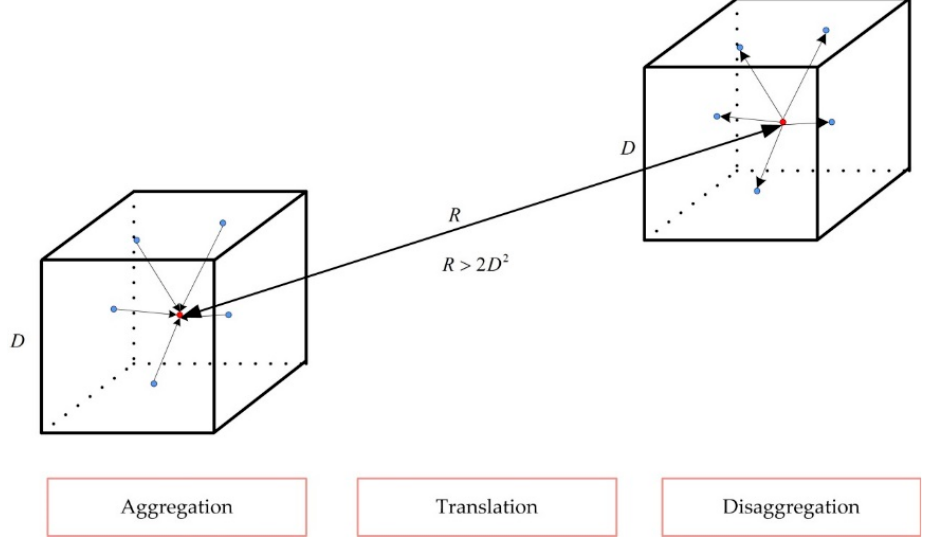
Figure 2. Far fi eld with FaFFA acceleration, including aggregation translation and disaggregation. Figure 2. Far field with FaFFA acceleration, including aggregation translation and